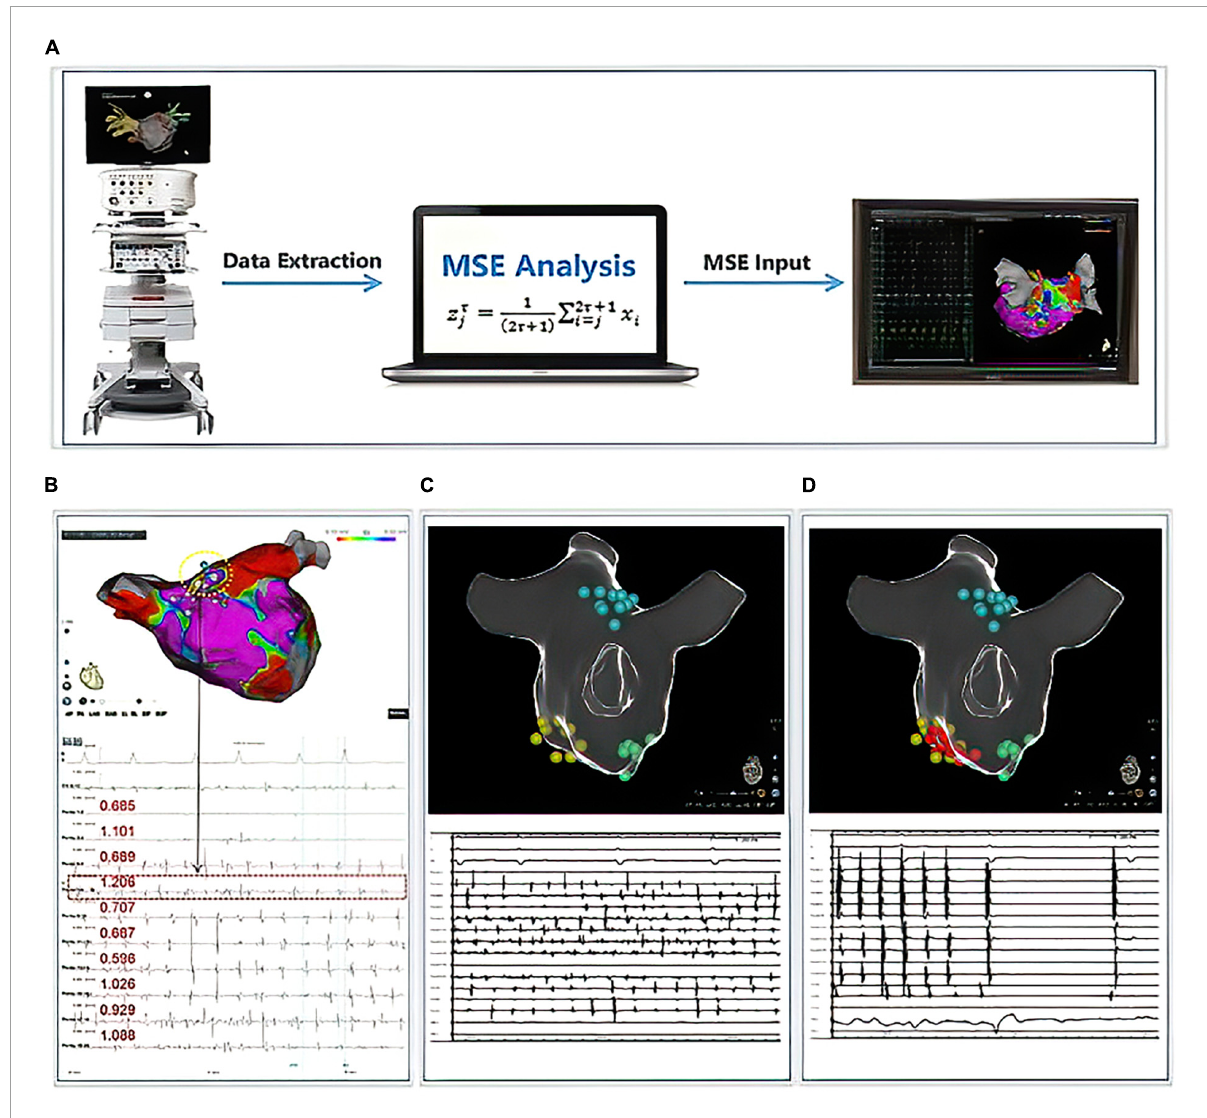
FIGURE2 Multiscale entropy (MSE) calculation process and cases display. Panel (A) demonstrated the workflow for the calculation of MSE. Panel (B) displayed 1 case with successful AF termination by mMSE-guided ablation. The termination sites were located in the dotted circles, and the MSE values were listed below. Panels (C,D) displayed another case; yellow points indicated the area with the highest mMSE value, green points indicated the area with the second highest mMSE value, blue points indicated the area with the third highest mMSE value. We ablated the area with yellow points, and the AF terminated into sinus rhythm during the ablation. Therefore, we stopped the mMSE-guided